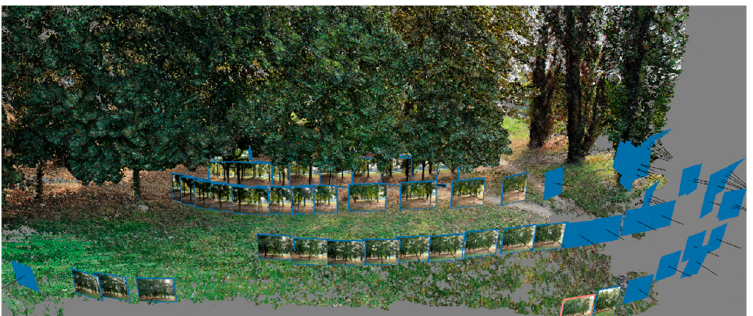
Figure 5. Dense point clouds of one of the investigated plots (AM model view); the blue squares represent the locations of the acquired images.